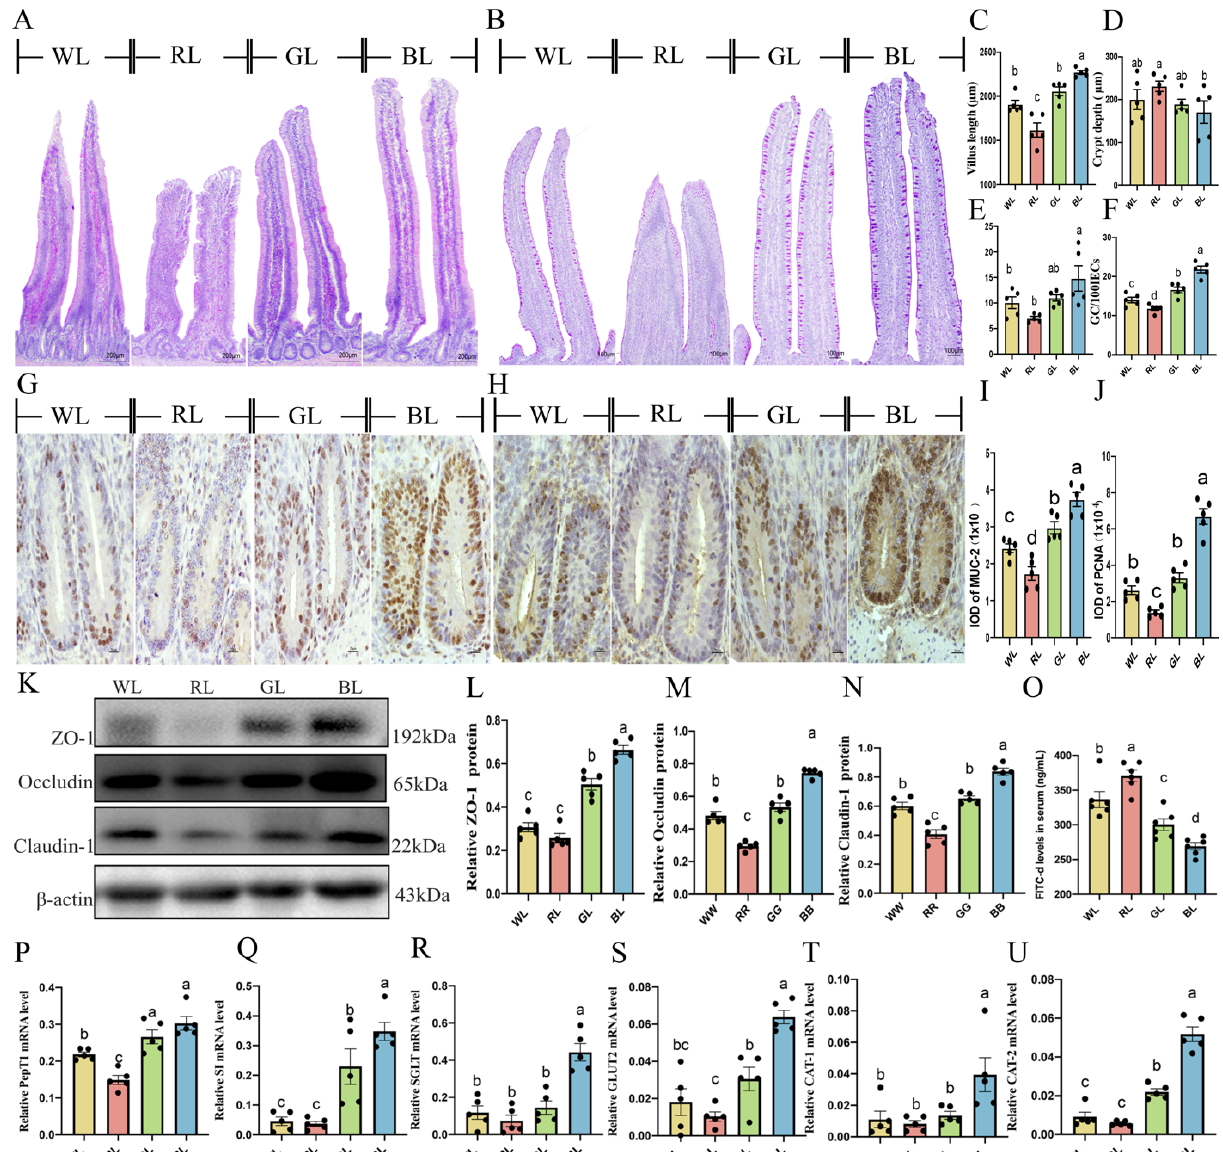
Figure 7. Effects of different monochromatic lights on HE staining of jejunal tissue sections ( A ), PAS staining of jejunal tissue sections ( B ), jejunal villus height (scale bar = 100 µ m) ( C ), jejunal crypt depth ( D ), jejunal villus height/crypt depth (V/C) ratio ( E ), goblet cell numbers (scale: 100 µ m) ( F ), immunohistochemical staining photographs of MUC-2 (scale: 20 µ m) ( G ), immunohistochemical staining photographs of PCNA (scale: 20 µ m) ( H ), IOD of MUC2-positive cells ( I ), IOD of PCNA-positive cells ( J ), ZO-1, Claudin-1 and Occludin protein expression ( K – N ), intestinal permeability ( O ), PepT1 mRNA level ( P ), SI mRNA level ( Q ), SGLT1 mRNA level ( R ), GLUT2 mRNA level ( S ), CAT-1 mRNA level ( T ), CAT-2 mRNA level ( U ) in chicks of WL, RL, GL and BL at P42. WL: white light; RL: red light; GL: green light; BL: blue light. These results are shown as means ± SEM. Differences between the four groups are presented in the form of different letters ( p < 0.05). PepT1, influx oligopeptide transporter peptide transporter 1; SI, sucrose-isomaltase; SGLT1, Na + -glucose cotransporter; GLUT2, glucose transporter type 2; CAT1, transporter 1 of cationic amino acid; CAT2, transporter 2 of cationic amino acid.